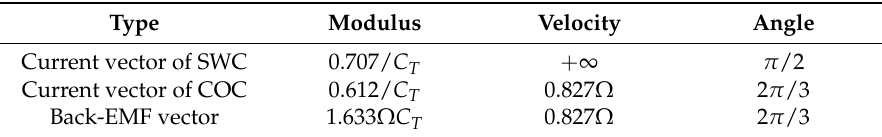
Table 1. The properties of current vector and back-EMF when θ r = 7 π /6. Type